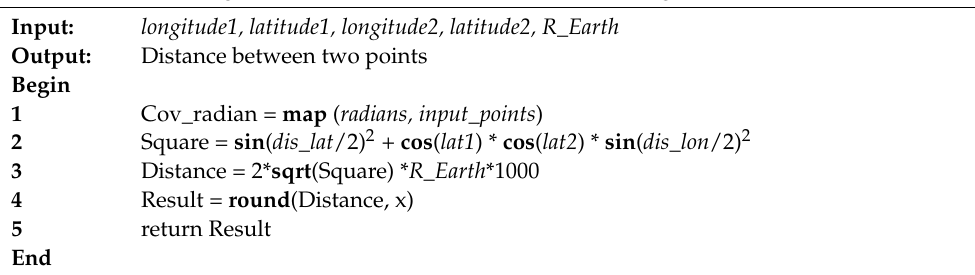
Algorithm 1 The Longitude and Latitude Distance Calculation Algorithm.